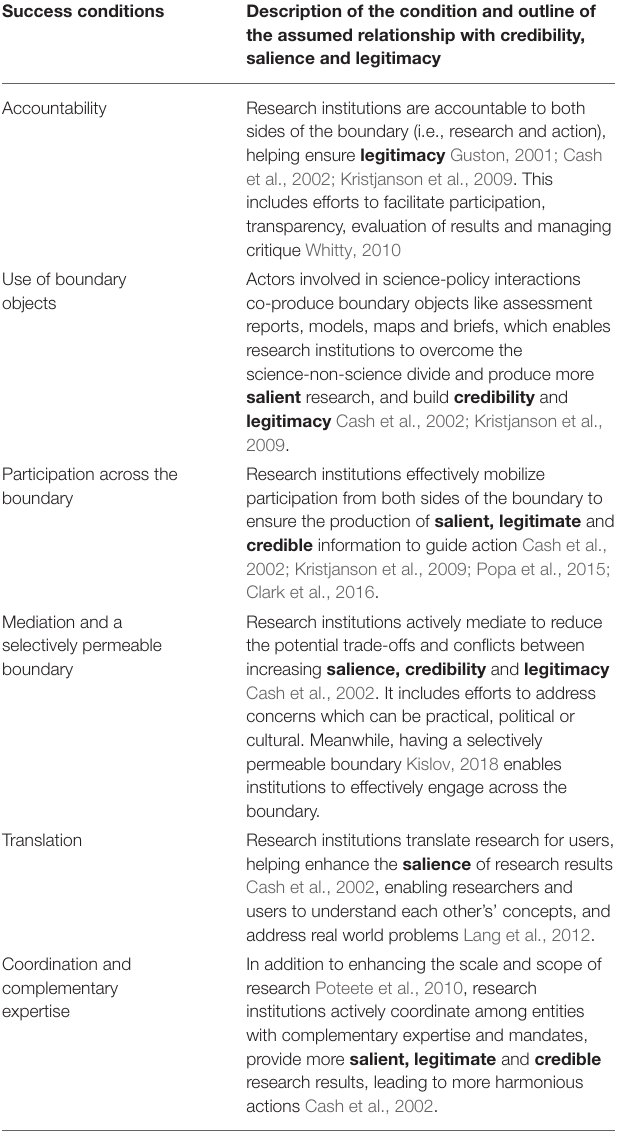
TABLE 2 | Framework for examining program efforts to enhance salience, credibility and legitimacy. Success